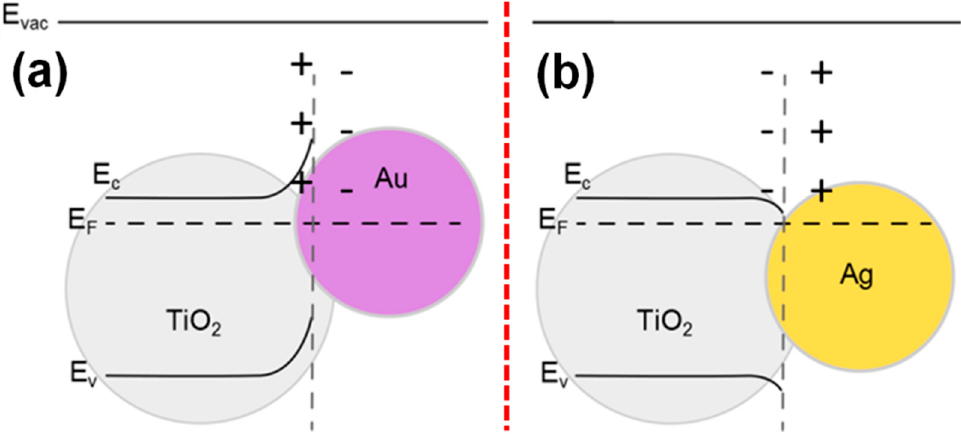
Figure 10. Work function dependent band-bending in ( a ) Au/TiO 2 , ( b ) Ag/TiO 2 plasmonic systems (reproduced with permission from ref. [139]).